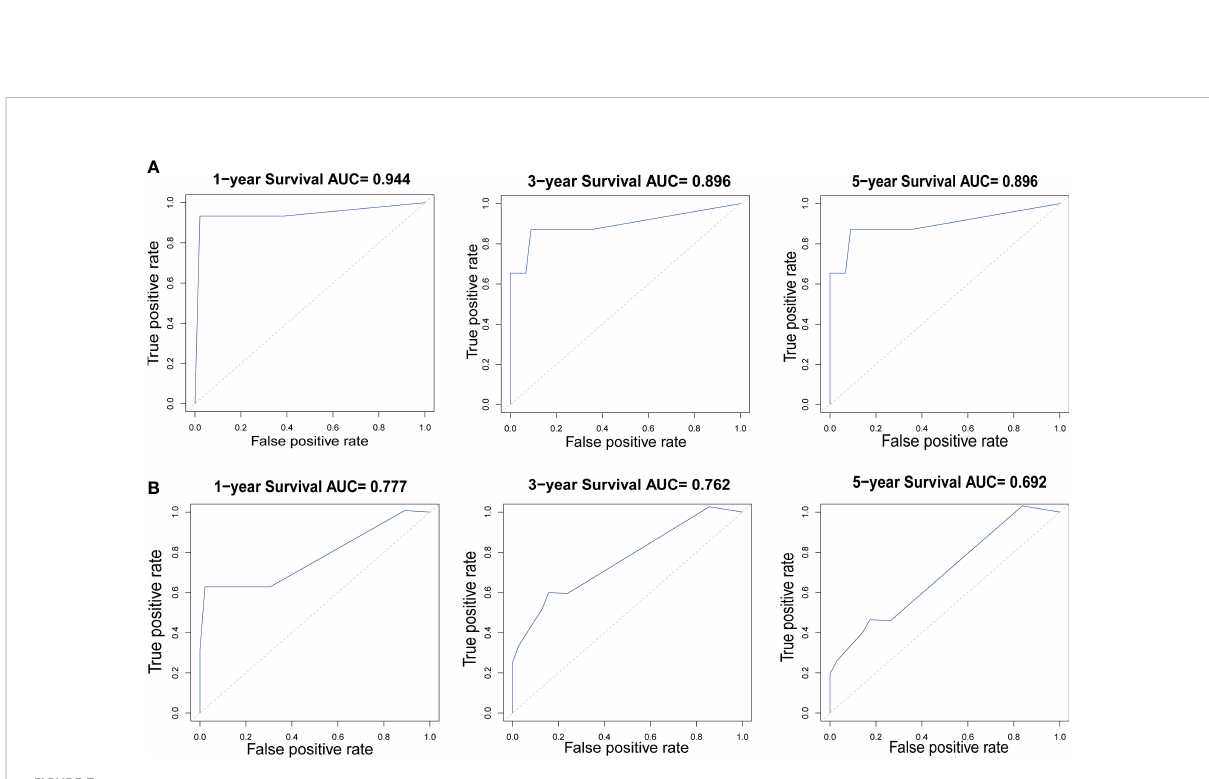
FIGURE 7 The ROC curves of the nomogram predicting 1-year, 3-year, and 5-year (A) CSS and (B) OS in the validation cohort.